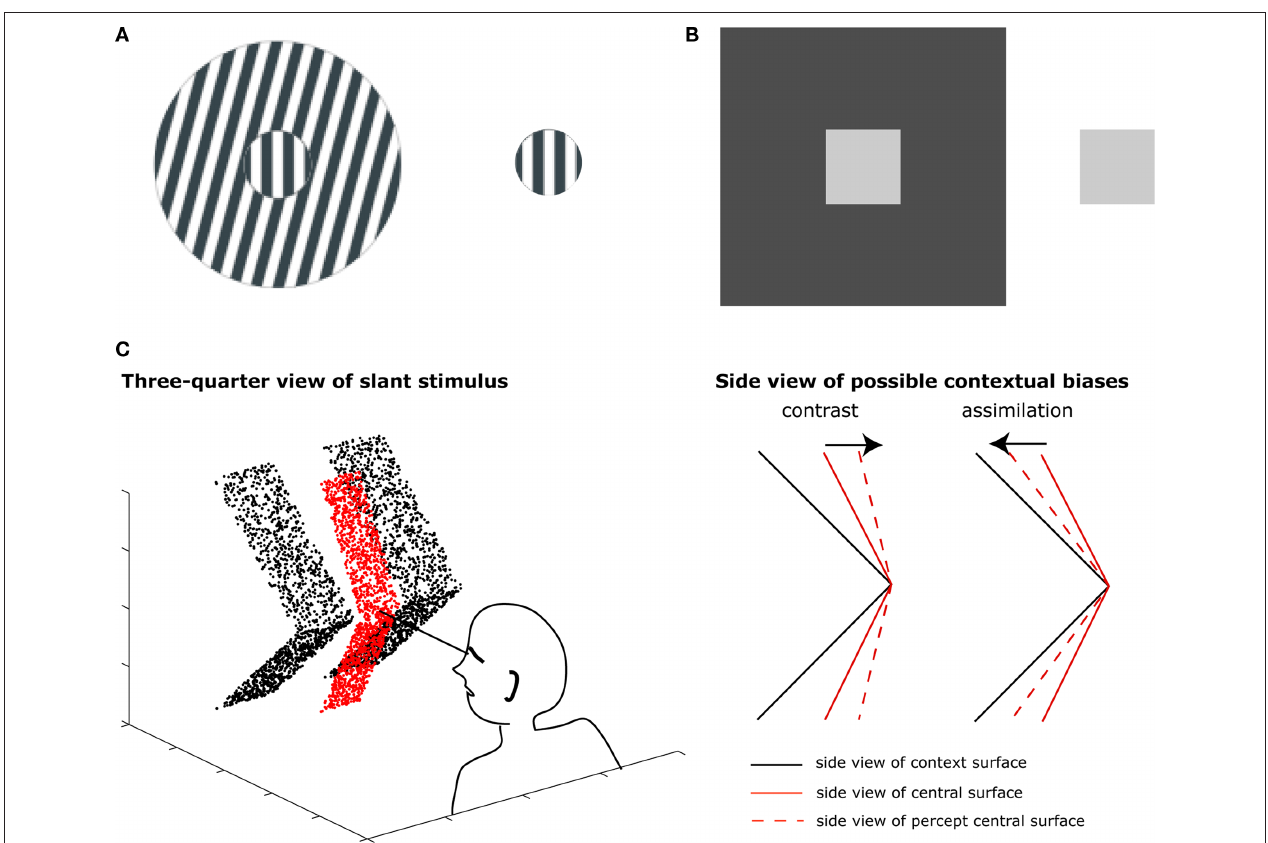
Figure 1 | (A) Tilt illusion. The vertical grating appears leftward tilted in the rightward tilted surround. (B) Color contrast. The gray patch appears lighter when presented on the darker surface. (C) Side view of stimulus used to induce slant contrast (van der Kooij and Te Pas, 2009a,b, 2010) and cartoon illustration of contrast and assimilation biases that may occur in